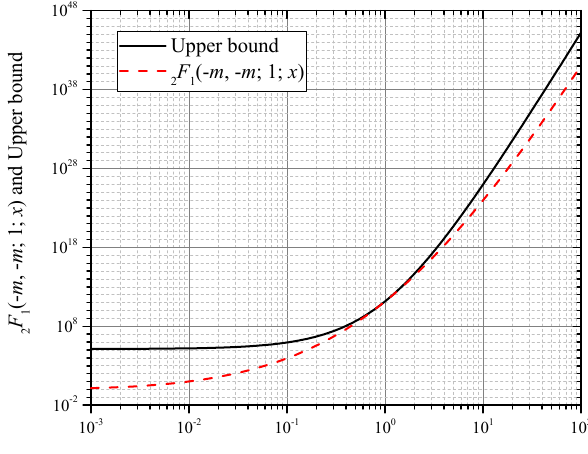
Figure 2. Simple upper bound for 2 F 1 ( − m , − m ;1; x ) , for m =